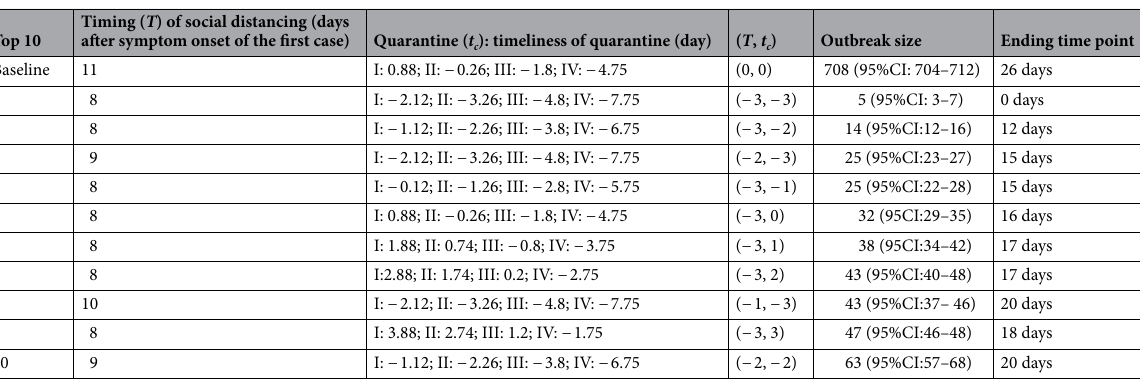
Table 3. Top ten cumulative number of interventions for a variant with R 0 = 6 and incubation period of 2 days, altering the timing of social distancing (phases II, III, IV) and timeliness of quarantine based on the Guangzhou